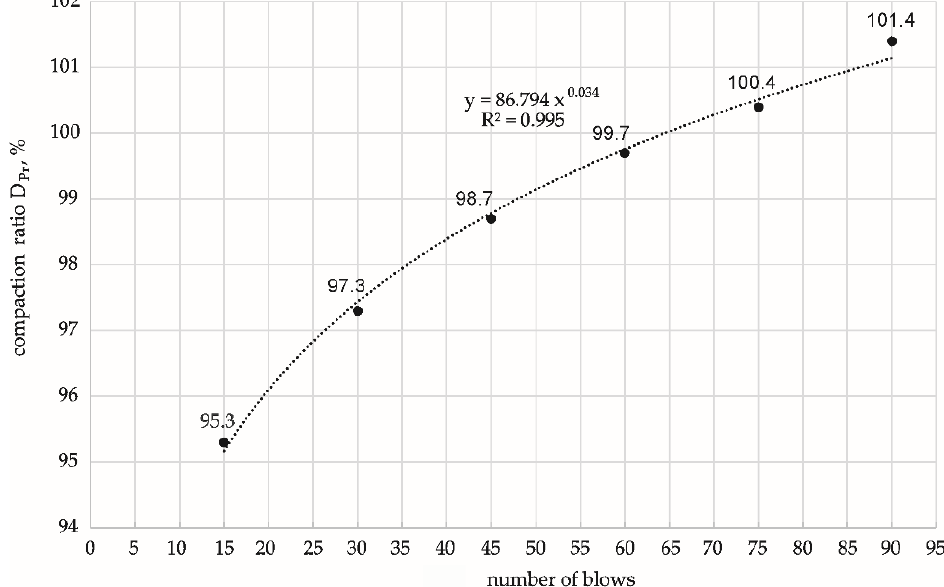
Figure 2. Dependence of the compaction ratio on the total number of hammer blows of the compaction.